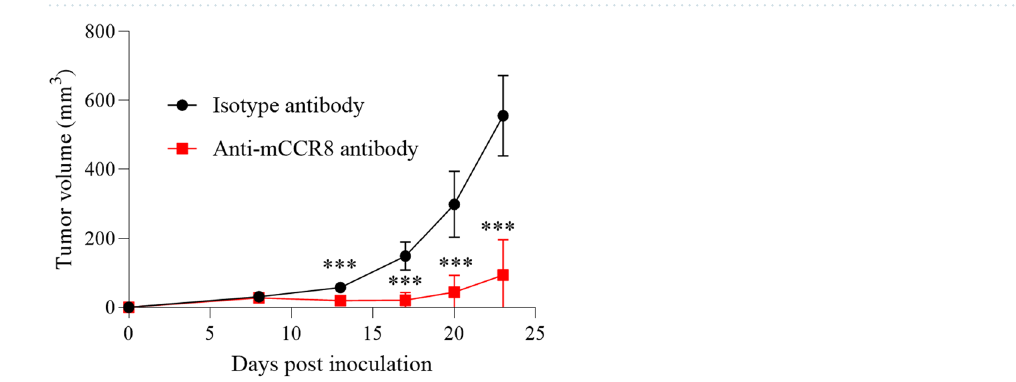
Figure 7. Anti-tumor effect of anti-CCR8 antibody in murine model of lung cancer. H-2 Kb-LLC cells were intradermally inoculated into C57BL/6 mice. At 3 and 8 days after tumor inoculation, the mice received intravenous injections of anti-CCR8 antibody or isotype control antibody (100 µg per mouse). Average tumor volumes are shown (n = 10 for each group). Statistical significance was determined by Mann–Whitney U test (*** p < 0.001). Data are shown as mean values ±